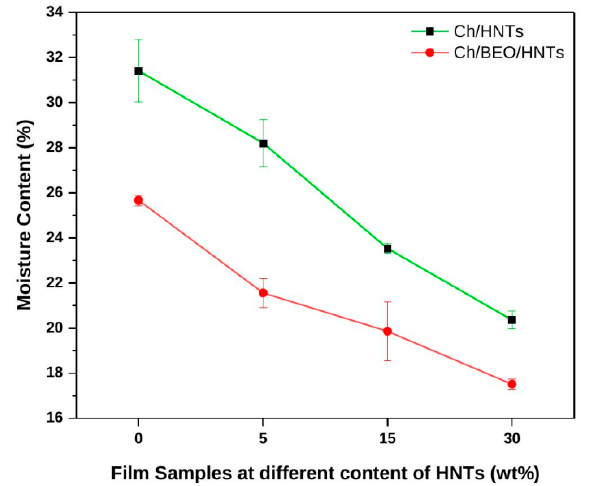
Figure 3. Moisture content of Ch films formulated with HNTs and BEO.